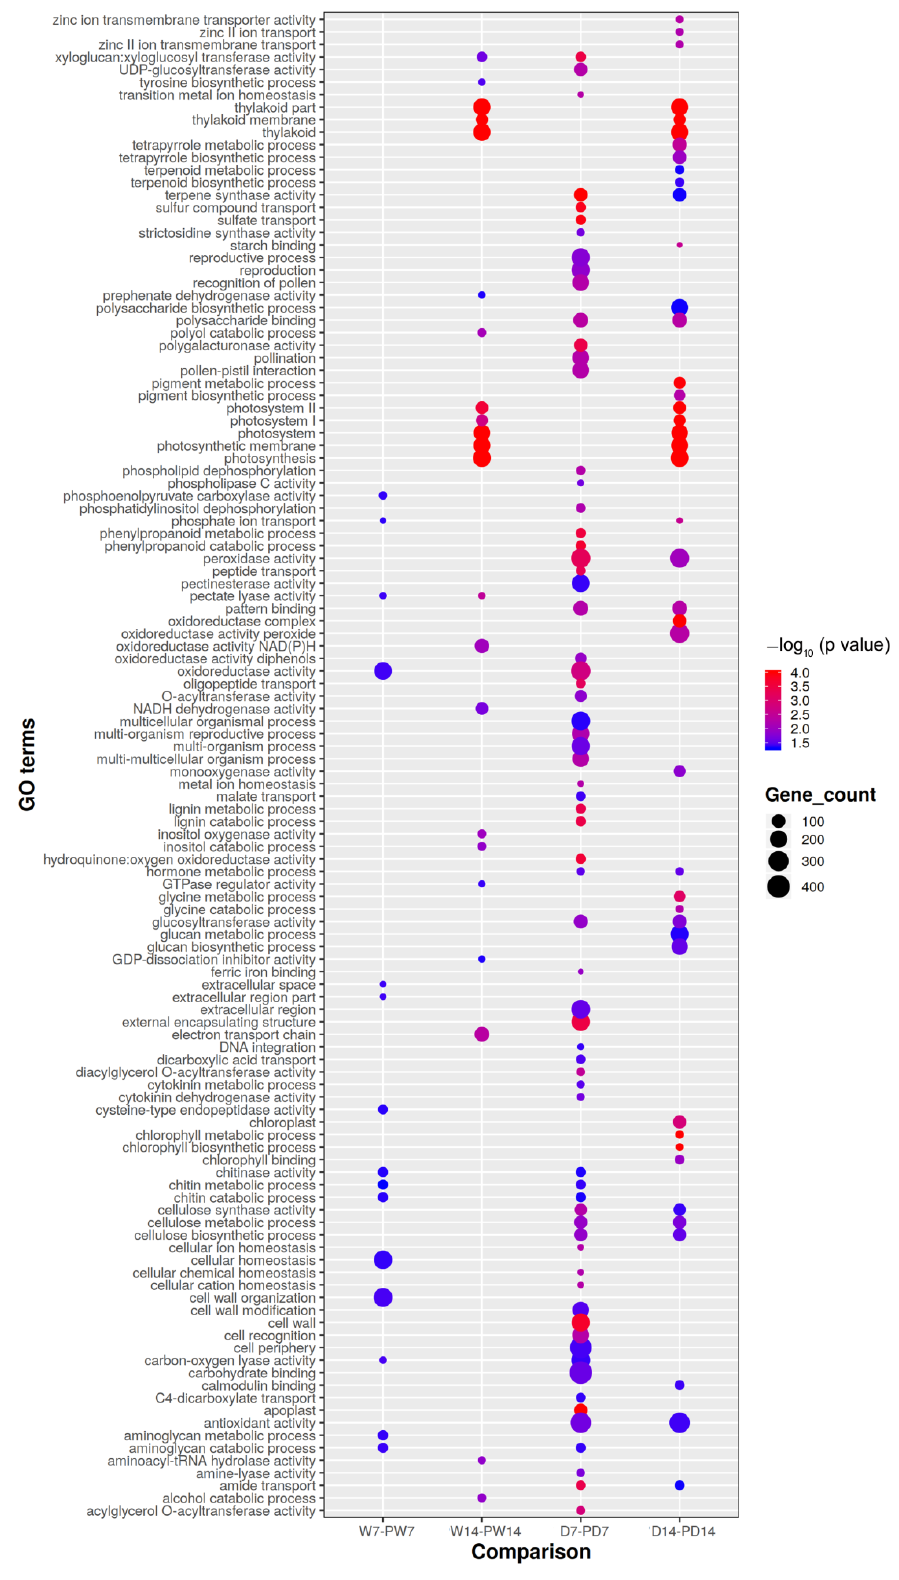
Figure 6. Comparison of GOs of DEGS induced by brassinolide priming under well-watered and drought conditions. Image showing the top 150 enriched gene ontology (GOs) of differentially expressed genes (DEGs) induced by seed priming with BR. GO enrichment was conducted against all GOs in peanut with statistical significance (hypergeometric test p < 0.05). W7, PW7, W14, PW14, D7, PD7,